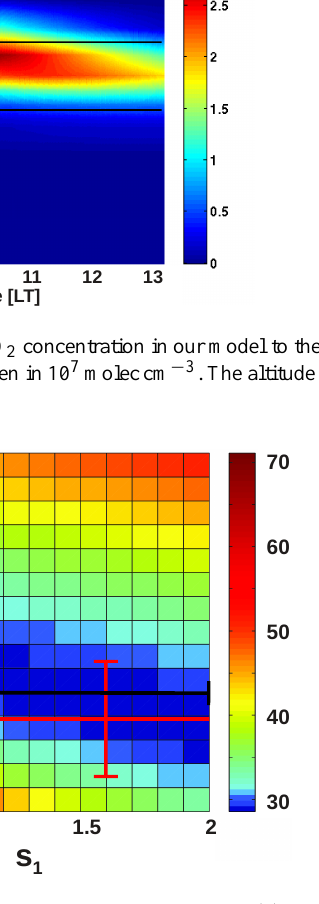
Fig. 6. χ 2 as a function of s 1 and s 2 , as given in Eq. (9). The inferred global minimum is shown in red together with the total error due to noise error of the retrieval. The corresponding JPL-2011 values are given in black.